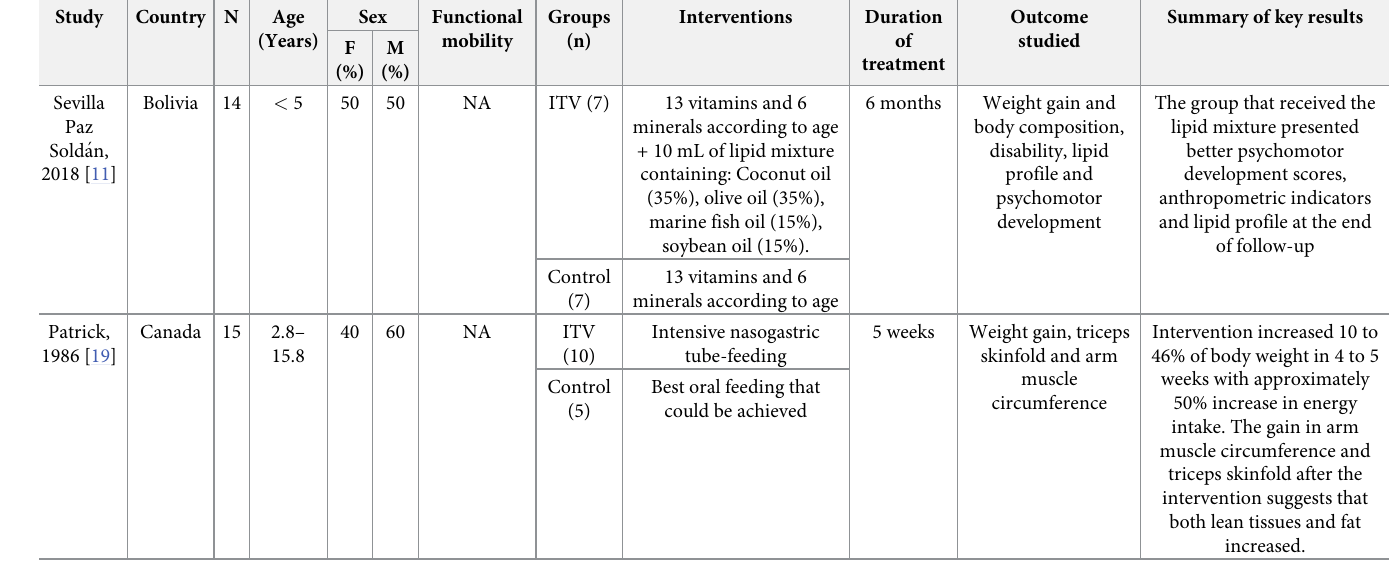
Table 3. Characteristics of the studies evaluating as main outcome anthropometric measurements and nutritional status.